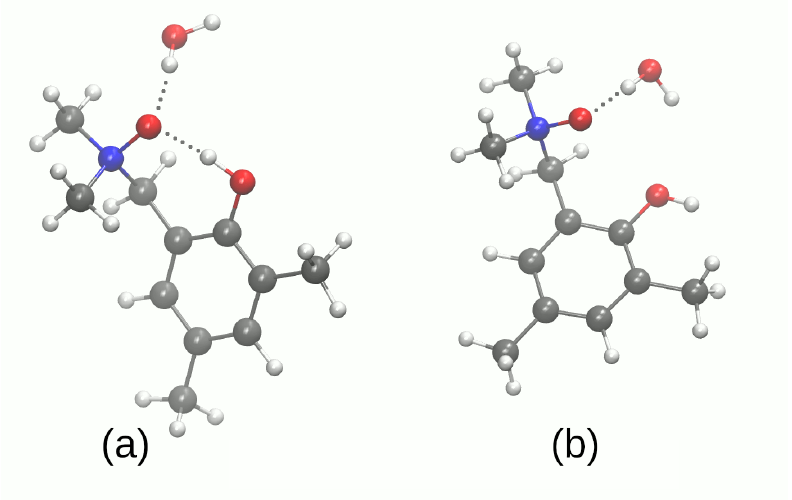
Figure 2. Conformers of the compound 1 (monohydrate form) computed at the B3LYP/6-311++G(d,p) level of theory. ( a ) closed form; ( b ) open